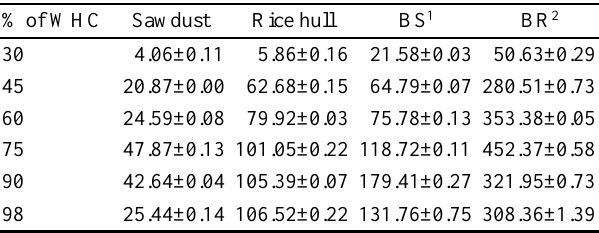
Table 3. Energy generated through biodegradation of bedding materials and beef manure mixtures % of WHC Sawdust